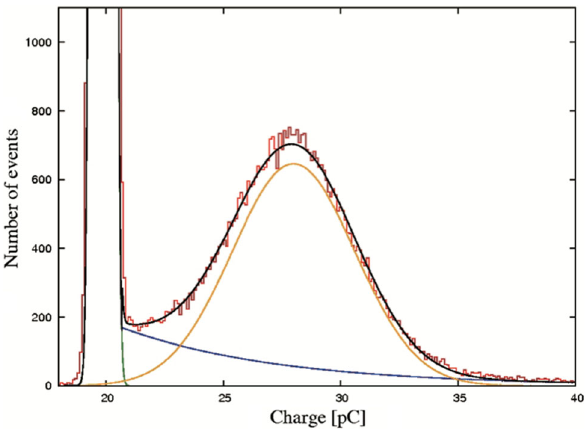
Fig. 20 Typical single photoelectron charge response [38]. Pedestal and SPE peaks are fit by two gaussians, adding an exponential to describe the valley region